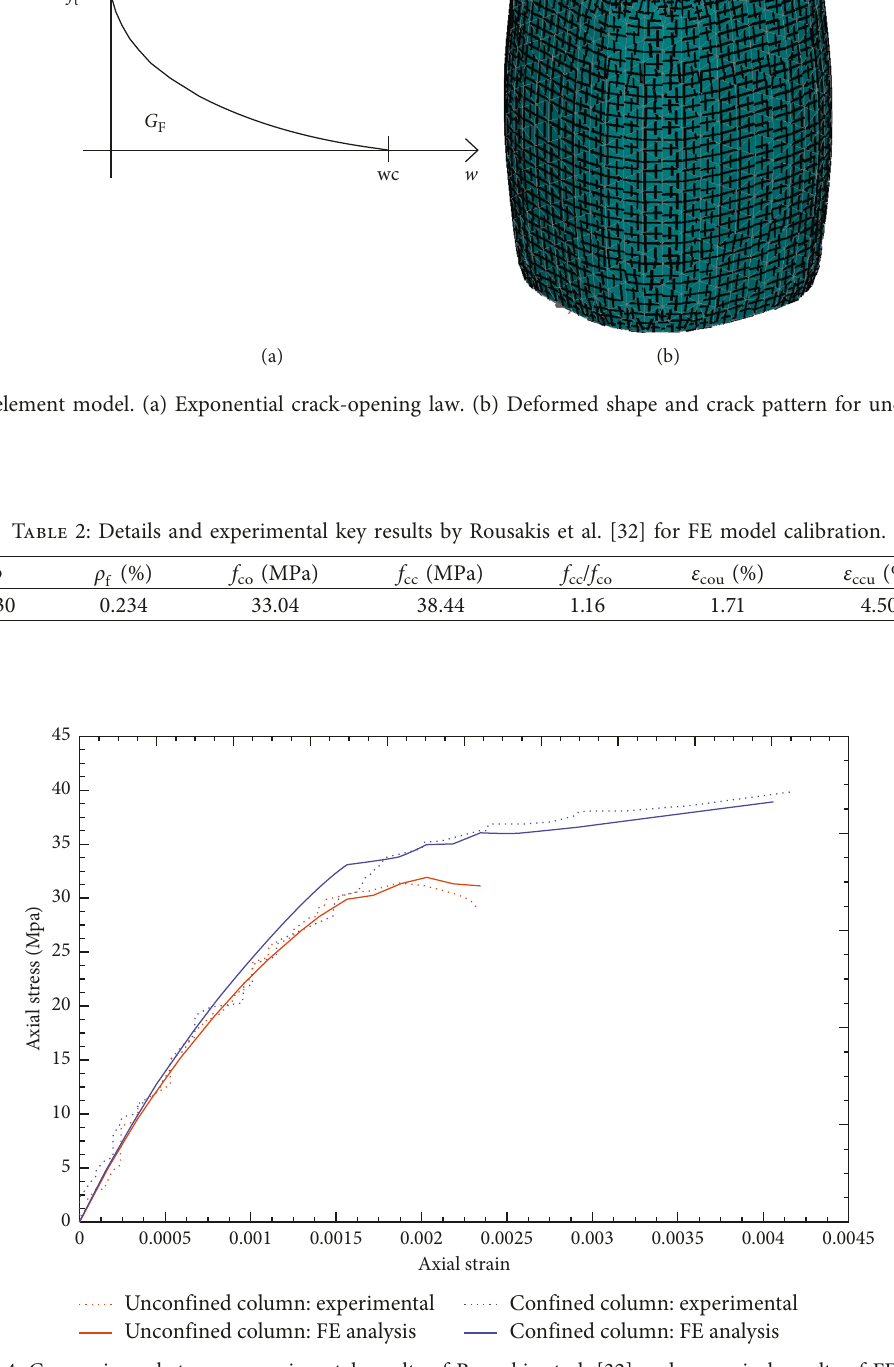
Figure 4: Comparisons between experimental results of Rousakis et al. [32] and numerical results of FE